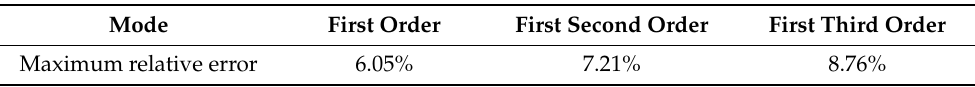
Table 4. Influence of retaining different order modes on the identification effect.